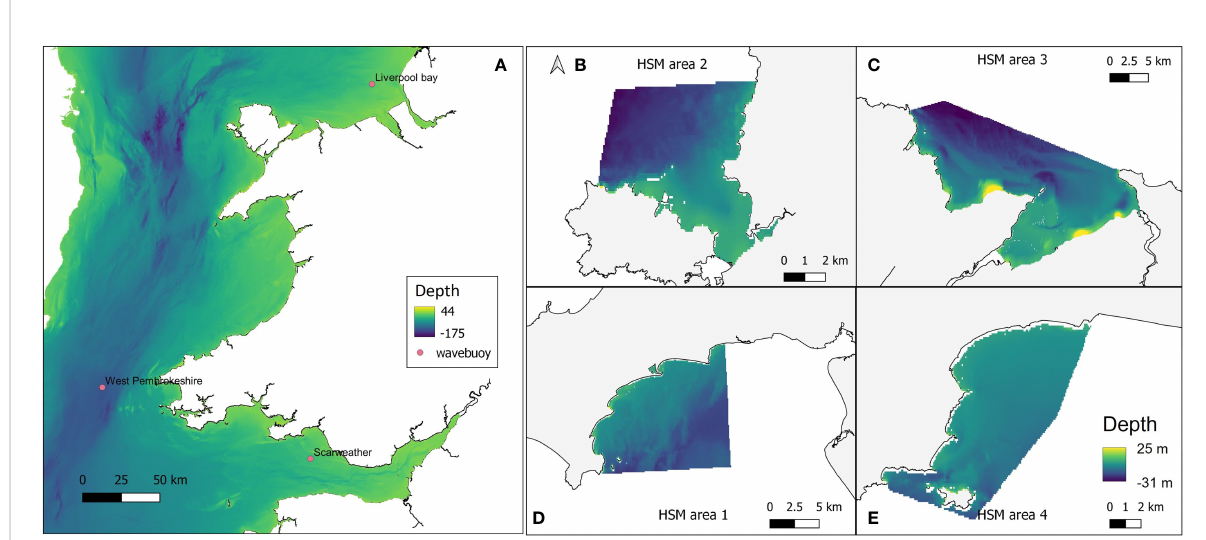
FIGURE 3 (A) Delft3D Large computational domain and bathymetry, encompassing the Irish Sea and extending towards the Atlantic Ocean. Pink markers indicate the positions of the Scarweather, West Pembrokeshire, and Liverpool Bay wave buoys. Grid cells are 1160 m x1850 m resolution. Nested model domains at (B) West Anglesey (area 2); (C) East Anglesey (area 3); (D) Llyn Peninsula (area 1); and (E) Pembrokeshire (area 4). Bathymetry data were taken from GEBCO and EMODnet datasets. Some topographical areas were also covered in this data layer which explains the high positive values in depth range, but would not have affected outputs as these areas would not be covered by water so were avoided in modelling.